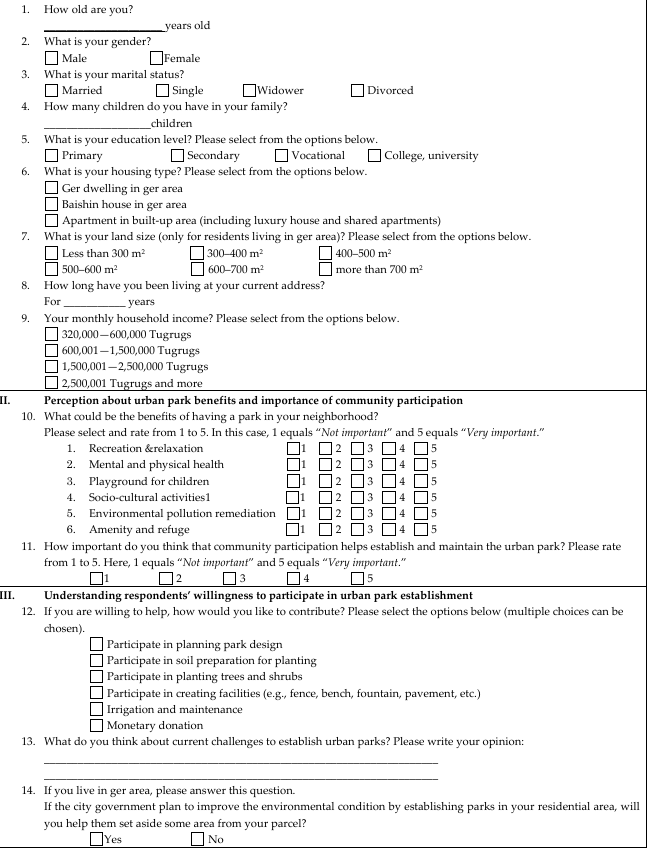
Table S2: correlation test for independent variables (ger and baishin respondents), Table S3: socio- demographic characteristics of the respondents by residential category.